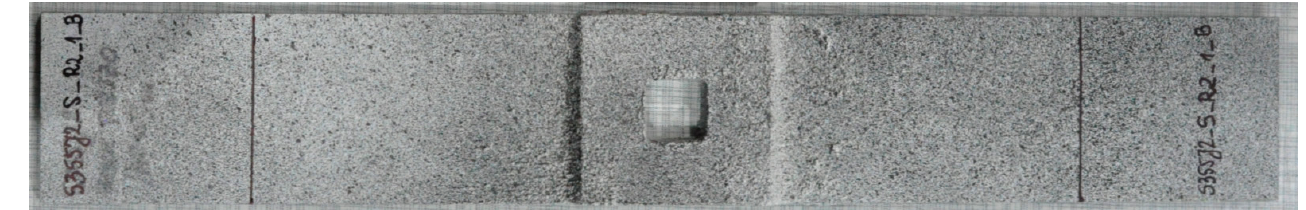
Figure 4. Photograph of tested samples 1–4 covered by speckle patterns.